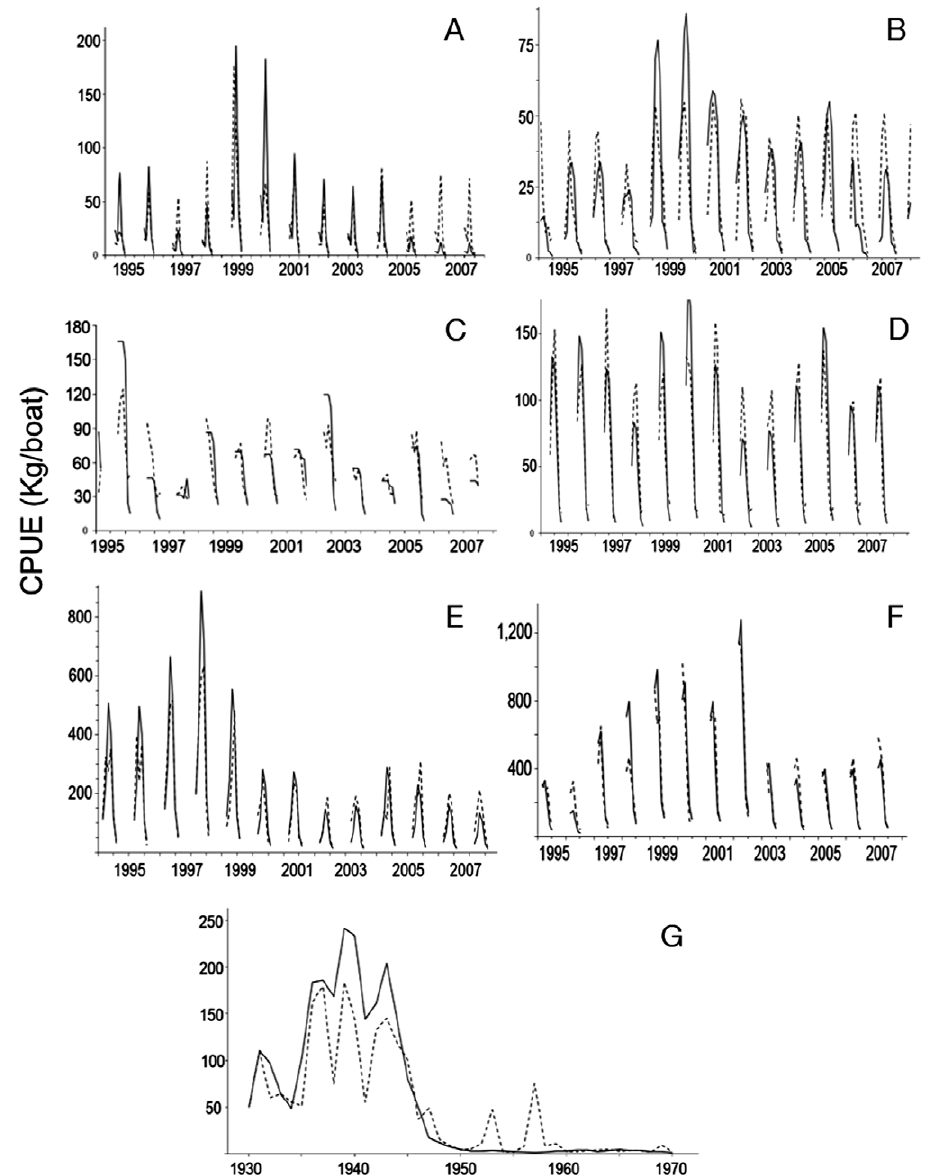
Fig. 2. – Observed CPUE values (solid line) and values estimated using GAMs (dashed line) for shark (A), ray (B), blue shrimp (C), Pacific sierra (D), chano (E), corvina (F) and totoaba